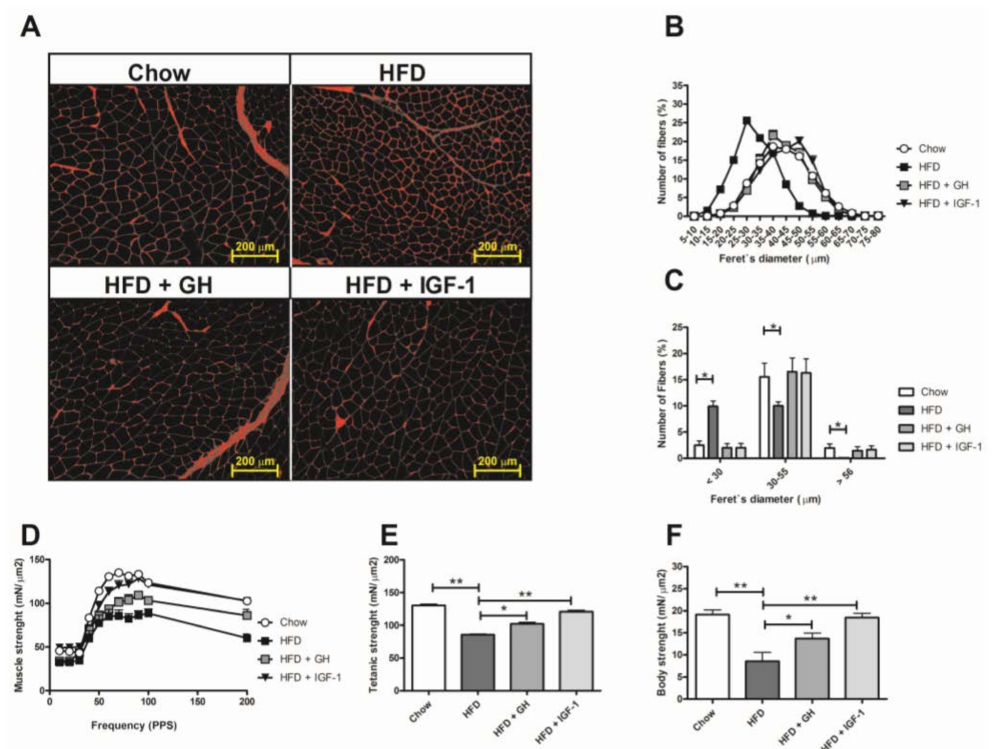
Figure 3. High fat diet induced sarcopenia that was fully reverted by somatotropic hormone supplementation. ( A ) Muscle histological sections with wheat germ agglutinin (WGA) fluorescence staining, ( B ) muscle fibre diameter distribution as determined by measure of the minimal feret’s diameter, ( C ) analysis of three muscle fibre size ranges. Thick (>56 Lm), medium size (30–55 Lm), and thin (<30 Lm) muscle fibres are shown. ( D , E ) electrophysiological analysis of TA muscle strength from both groups including twitch and tetanus contractions. ( F ) Body strength in vivo. * p < 0.05; ** p < 0.01; N.D., not detectable.